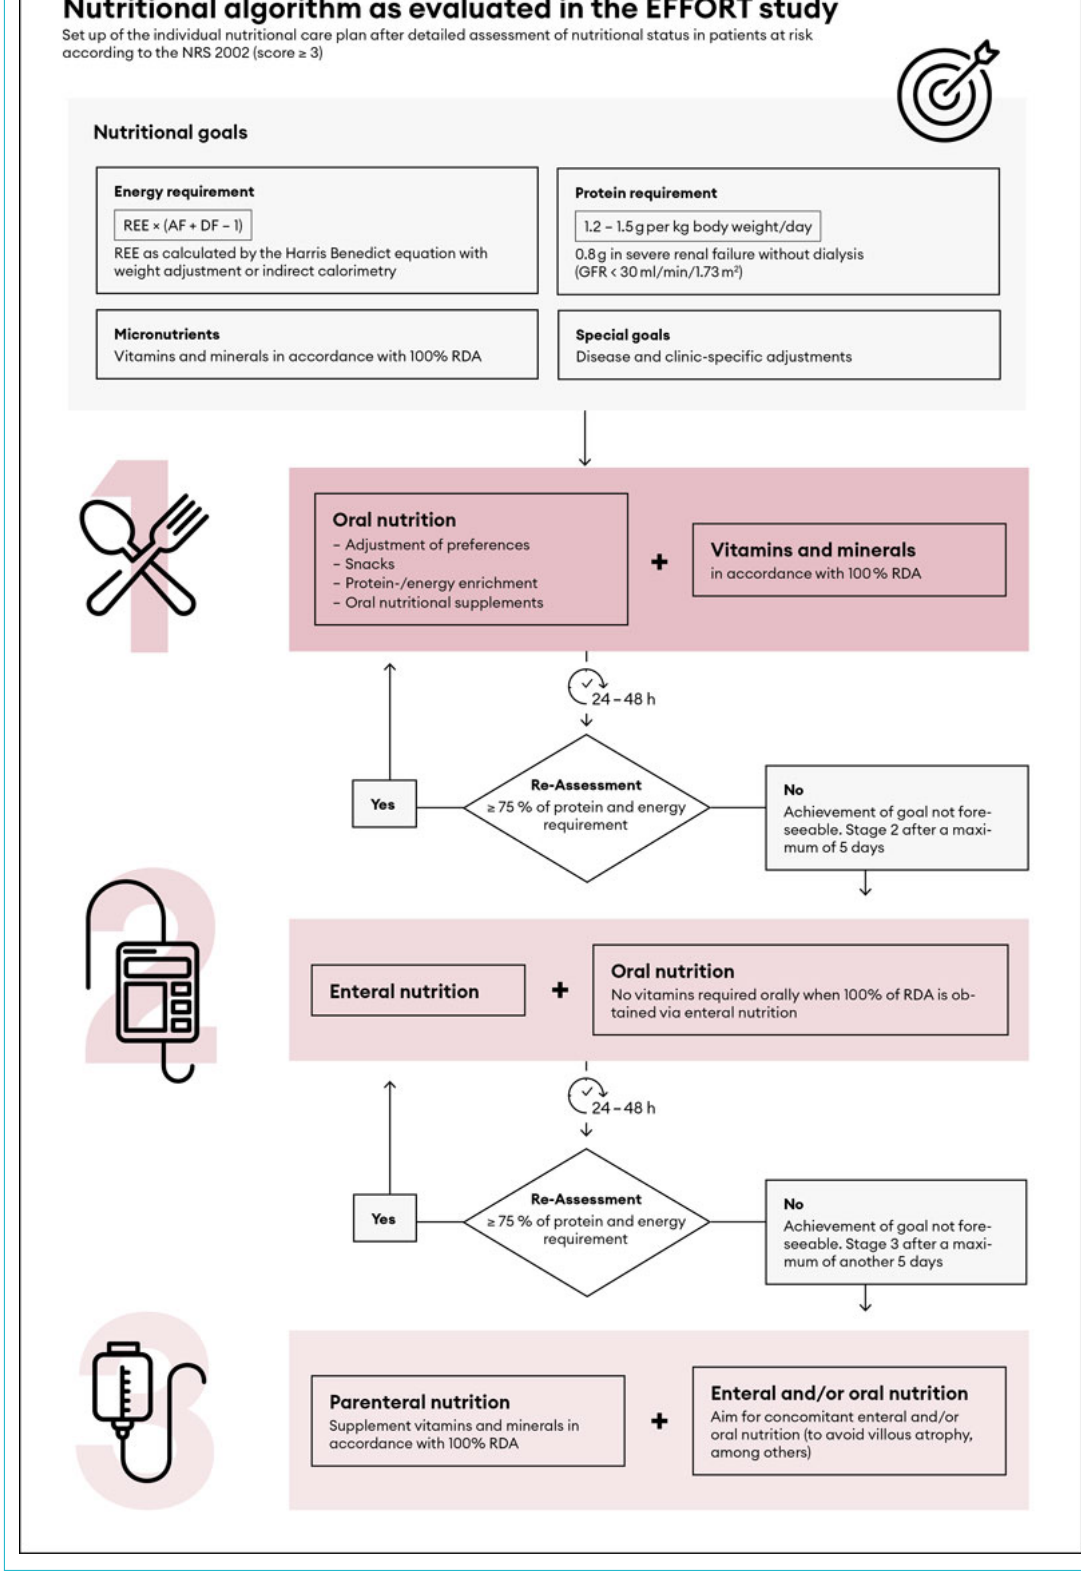
Figure 2: Algorithm flow chart for nutritional support in medical inpatients, adapted from Bounoure et al. [17] with permission from Elsevi- er.REE = resting energy expenditure; AF = activity factor; DF = disease factor; RDA = recommended daily allowance; GFR = glomerular filtra- tion